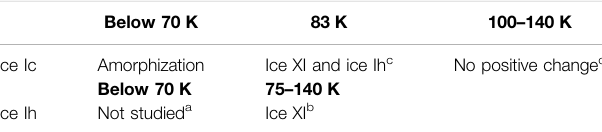
TABLE 1 | Summary of the observed structural changes of ice Ic and ice Ih during UV